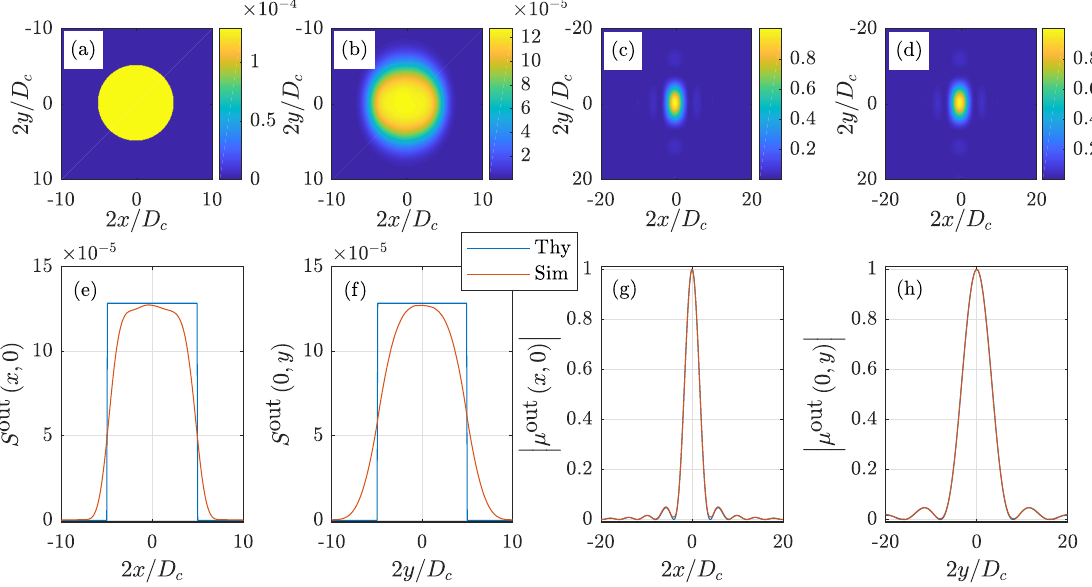
Figure 3. Simulation results demonstrating coherence control using a spatial filter: ( a ) S out,thy obtained from Equation (16); ( b ) S out,sim ; ( c ) µ out,thy given in Equation (21); ( d ) µ out,sim ; ( e ) y = 0 slices of S out,thy and S out,sim ; ( f ) x = 0 slices of S out,thy and S out,sim ; ( g ) y = 0 slices of µ out,thy and µ out,sim ; and ( h ) x = 0 slices of µ out,thy and µ out,sim